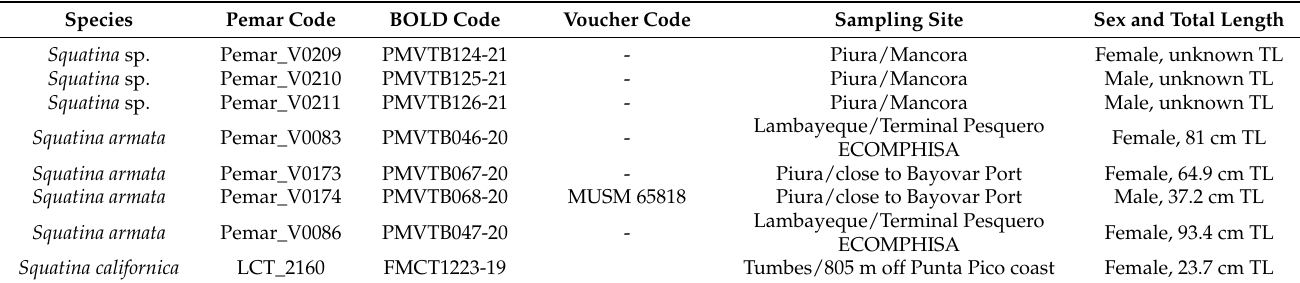
Table 1. Angel shark species sampled along the northern Peruvian coast, PeMar project code, BOLD code, voucher code, sampling site (region and exact site), sex, and total length